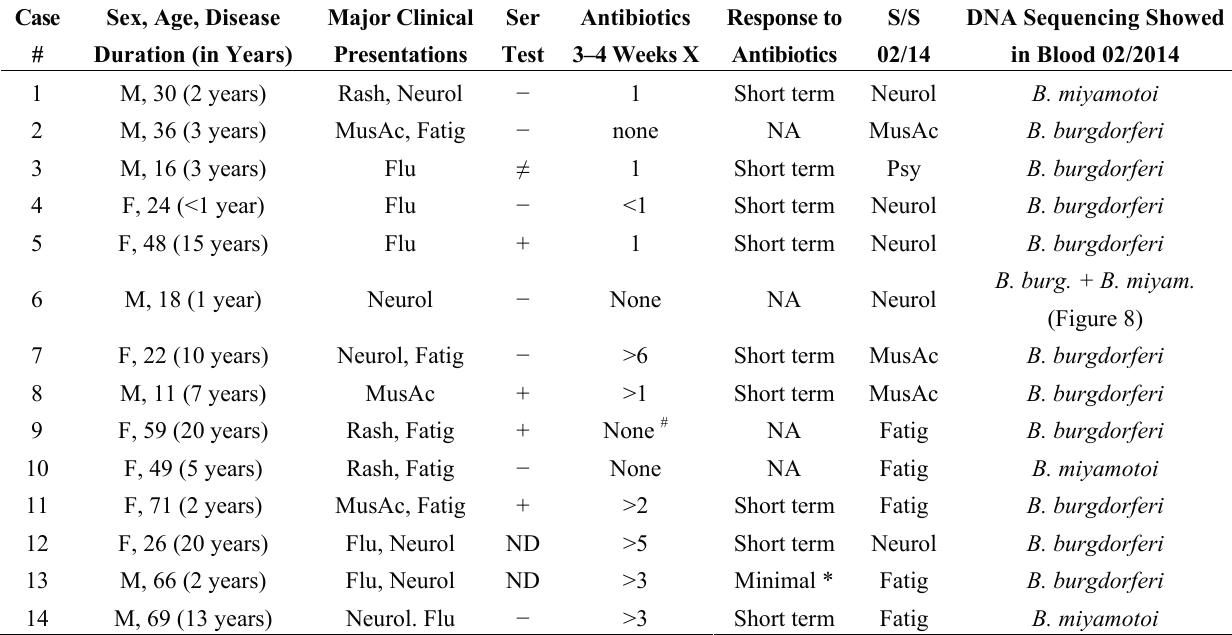
Table 2. Clinical histories of 14 patients of spirochetemia with low bacterial